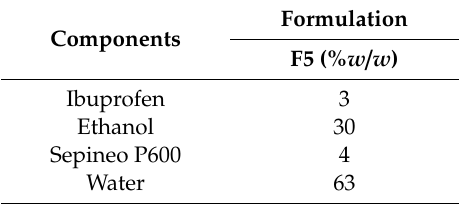
Table 2. Composition of optimized Emulgel in the study.